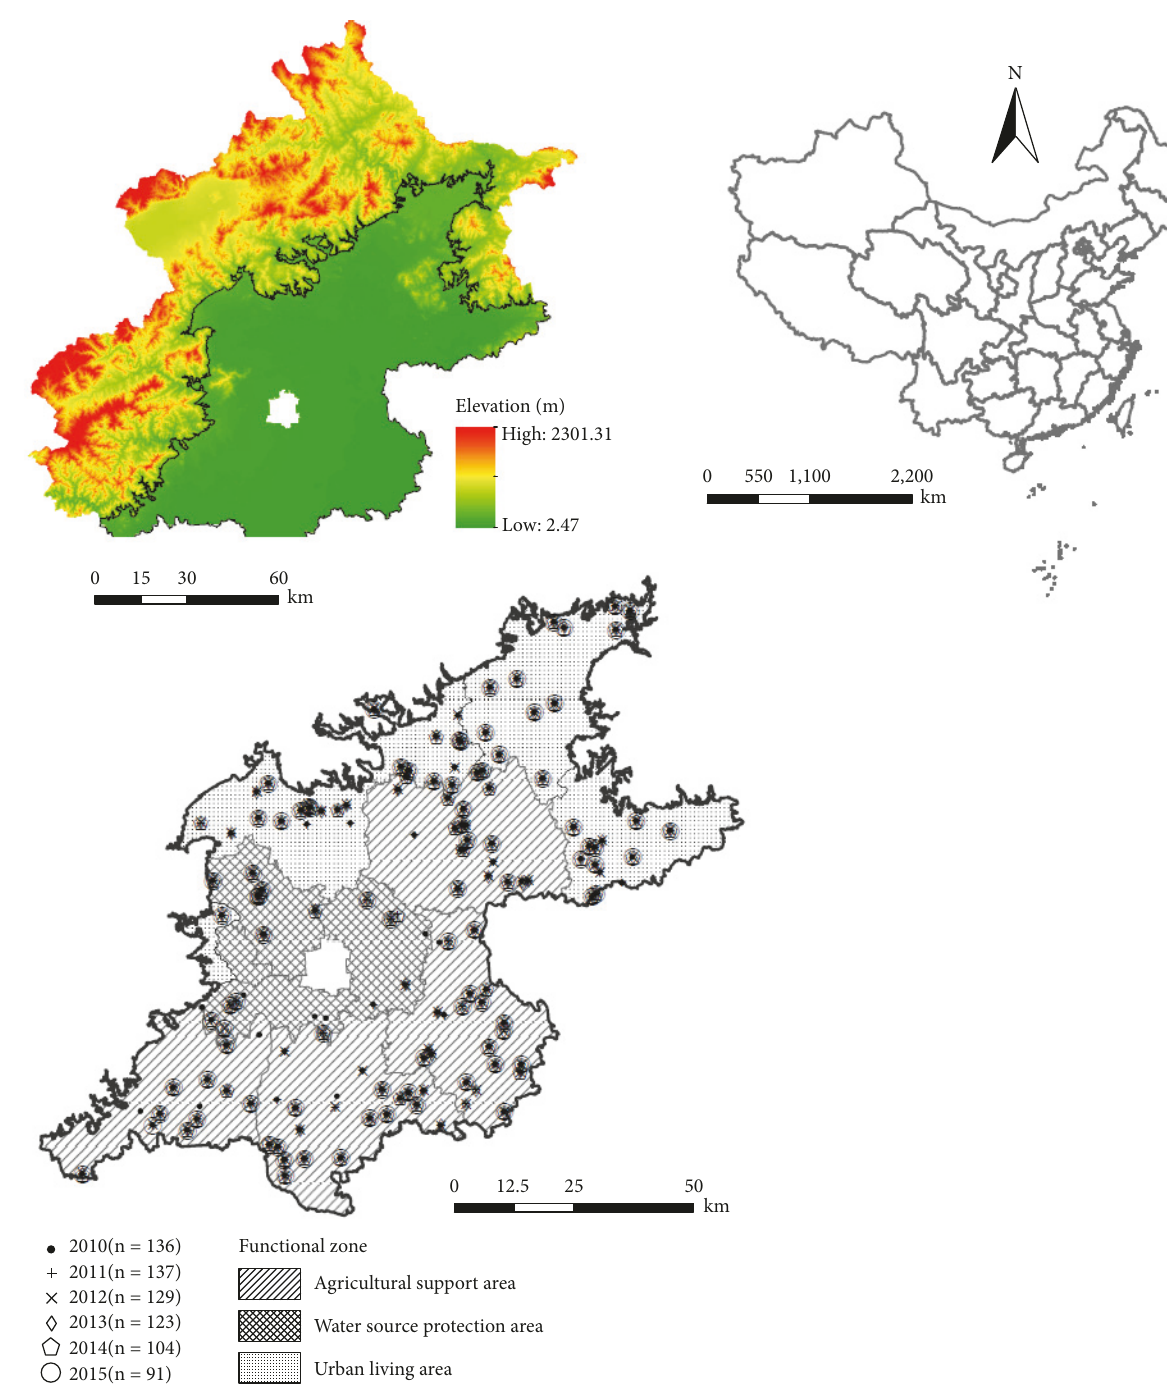
Figure 1: Map of the study area, sampling points, and functional